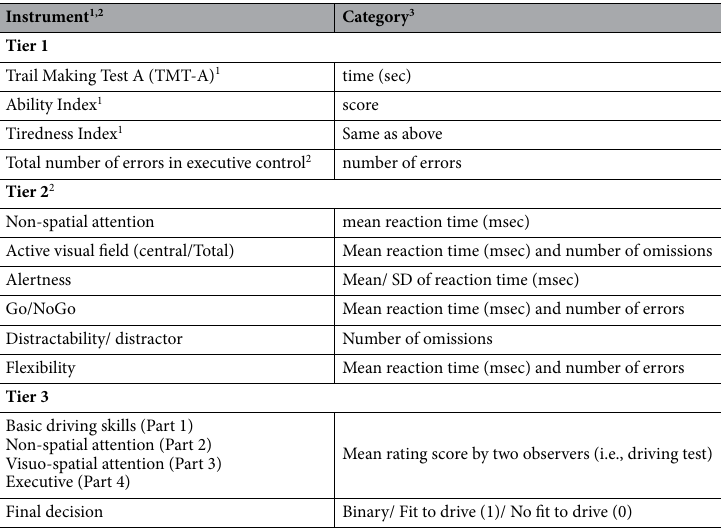
Table 1. Variables per Tier. 1 Pen and paper standardized test or questionnaire. 2 Computerised neuropsychological assessment (TAP-M). 3 All variables are continuous unless stated otherwise.